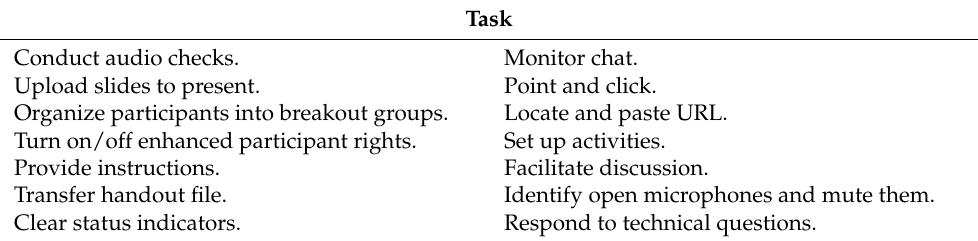
Table 4. Online skills for educators in a virtual class environment.